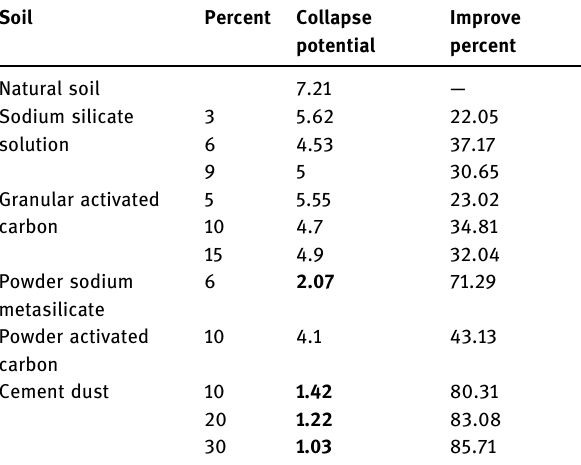
Table 4: Degree of collapse potential improved Soil Percent Collapse